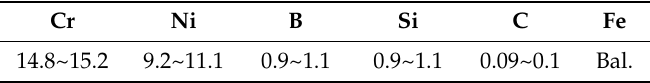
Table 1. Chemical composition of the Fe-based alloy (wt.%).